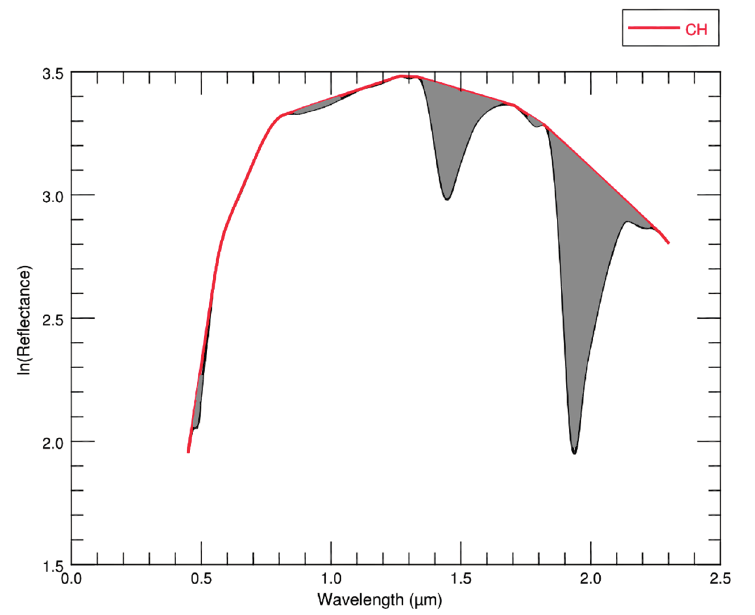
Figure 7. Example of a bare soil sample natural logarithm reflectance (black line) with its convex hull (red line). The area calculated between the spectrum curve and the CH is displayed in